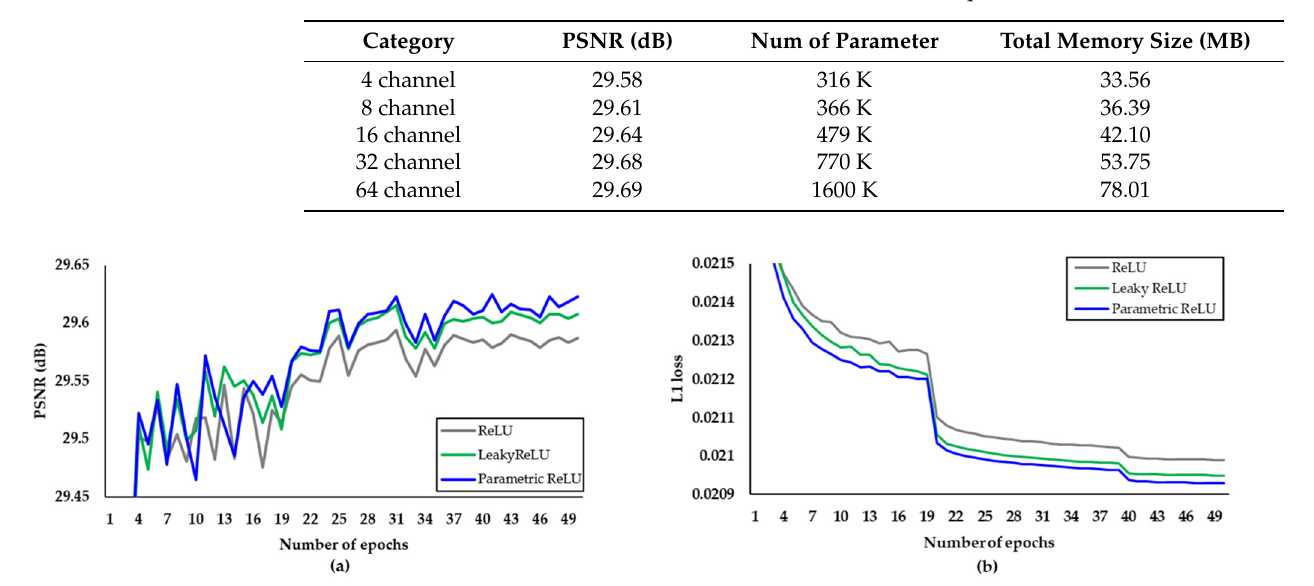
Table 3. Verification test on the number of concatenated feature maps within the DC block.